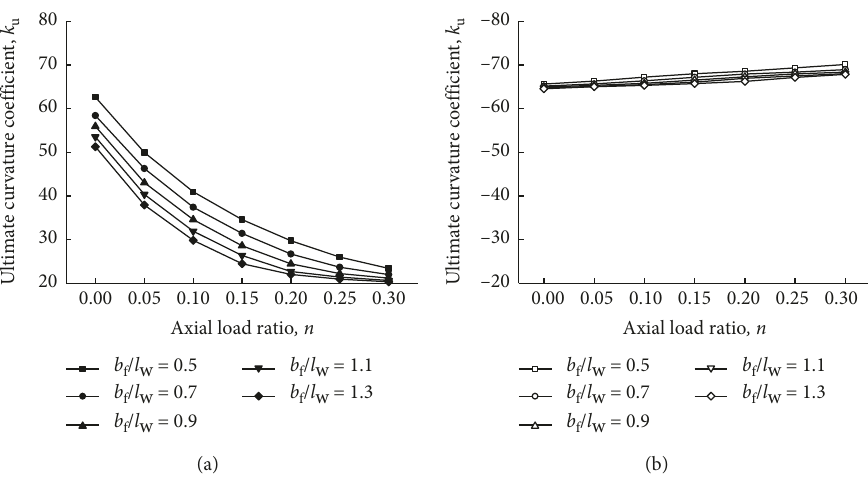
Figure 17: Variations in the ultimate curvature coefficient with the axial load ratio at different flange width to web height ratios. (a) Flange in tension. (b) Flange in compression.